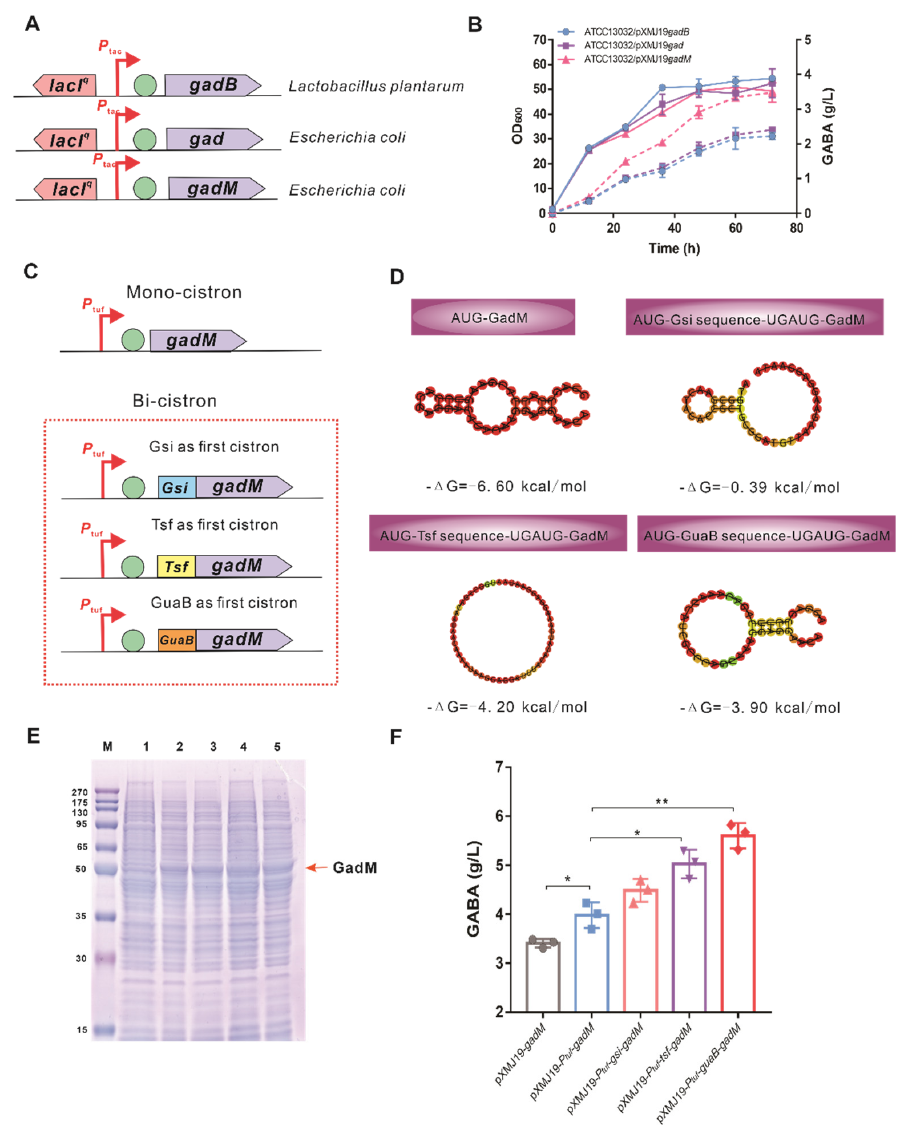
Figure 2. Construction and optimization of GAD ‐ based GABA synthetic pathway. ( A ) Construction of an inducible ‐ controlled expression cassette responsible for GABA synthesis. Three GADs encoded by gad and gadM genes from E. coli as well as the gadB gene from Lactobacillus plantarum were overexpressed under the P tac promoter control, respectively. ( B ) Fermentation profiles of C . glutamicum strains overexpressing different gad genes in shake flask cultivations. The solid lines represent the growth, and the dotted lines represent the GABA concentration. ( C ) The mono ‐ cistronic and bi ‐ cistronic expression cassettes of GadM under the control of a constitutive promoter P tuf . ( D ) RNAFold depiction of the mRNA secondary structures with the corresponding minimum free energy ( Δ G) for mono ‐ cistronic and bi ‐ cistionic ( Gsi , Tsf , GuaB ‐ fused GadM ) sequences. ( E ) Expression of GadM detected by SDS ‐ PAGE in C. glutamicum ATCC13032. Lane 1, crude protein extract from C. glutamicum /pXMJ19; Lane 2, crude protein extract from C. glutamicum /pXMJ19 ‐ P tuf ‐ gadM ; Lane 3, crude protein extract from C. glutamicum /pXMJ19 ‐ P tuf ‐ gsi ‐ gadM ; Lane 4, crude protein extract from C. glutamicum /pXMJ19 ‐ P tuf ‐ tsf ‐ gadM ; Lane 5, crude protein extract from C . glutamicum /pXMJ19 ‐ P tuf ‐ guaB ‐ gadM . ( F ) GABA productions of C . glutamicum harboring different expression cassettes of GadM in shake flask cultivations. Data are presented as mean values with the standard deviation from three biological replicates. Significant differences were determined using Student’s t test (* p < 0.05, ** p < 0.01).